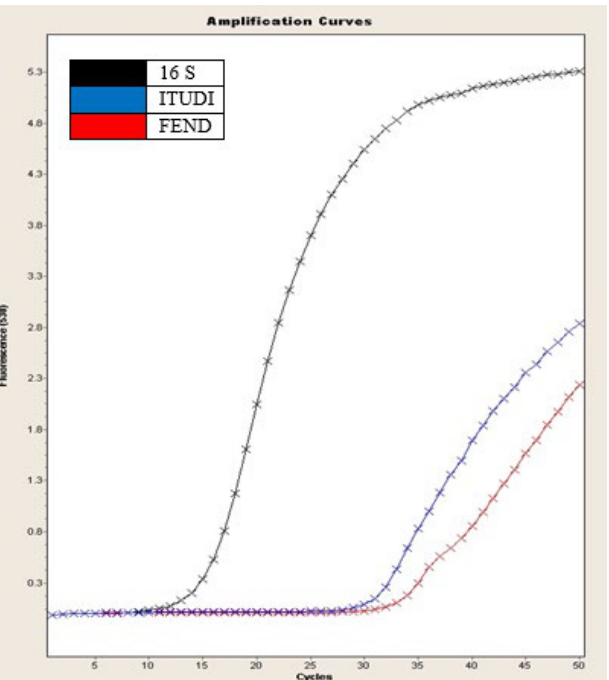
Fig. 2. 16S gene amplification curve, FEND, ITUDI of Bacillus megaterium vs Alternaria sp. at day 5 (LightCycler®,